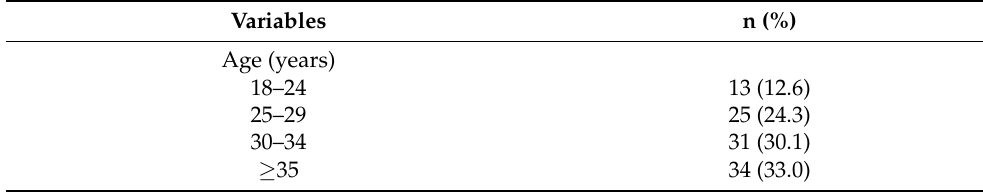
Table 1. Sociodemographic